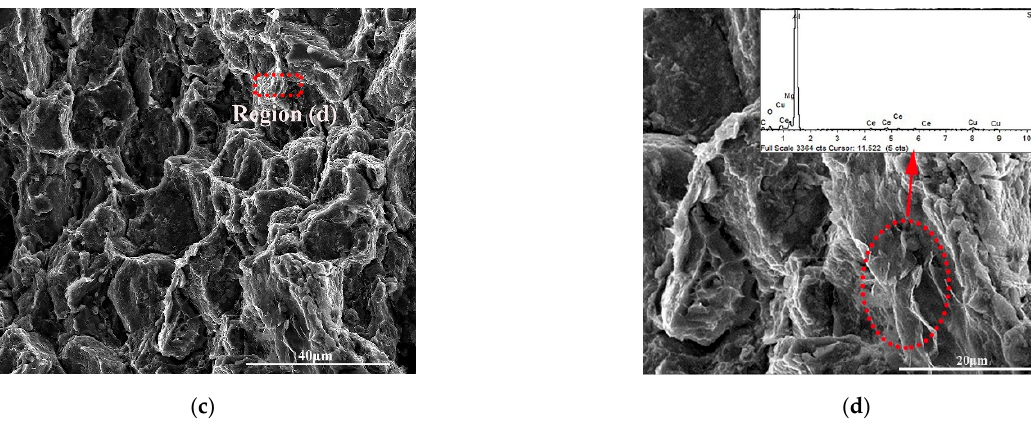
Figure 9. SEM images showing the fracture surfaces of the as-drawn ( a , b ) 0.5 wt.% GNPs/2024Al composites and ( c , d ) 0.5 wt.% CeO 2 -GNPs/2024Al composites.